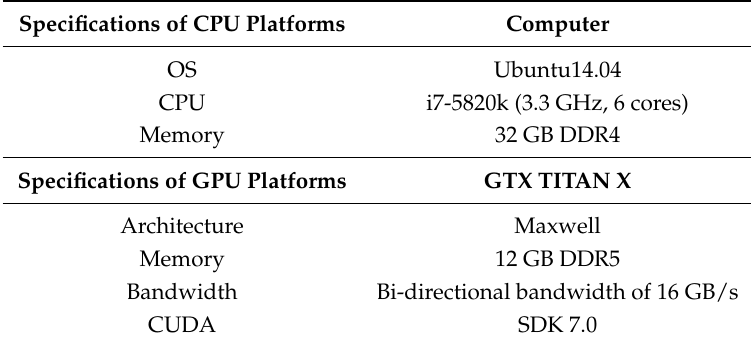
Table 2. Configurations of the